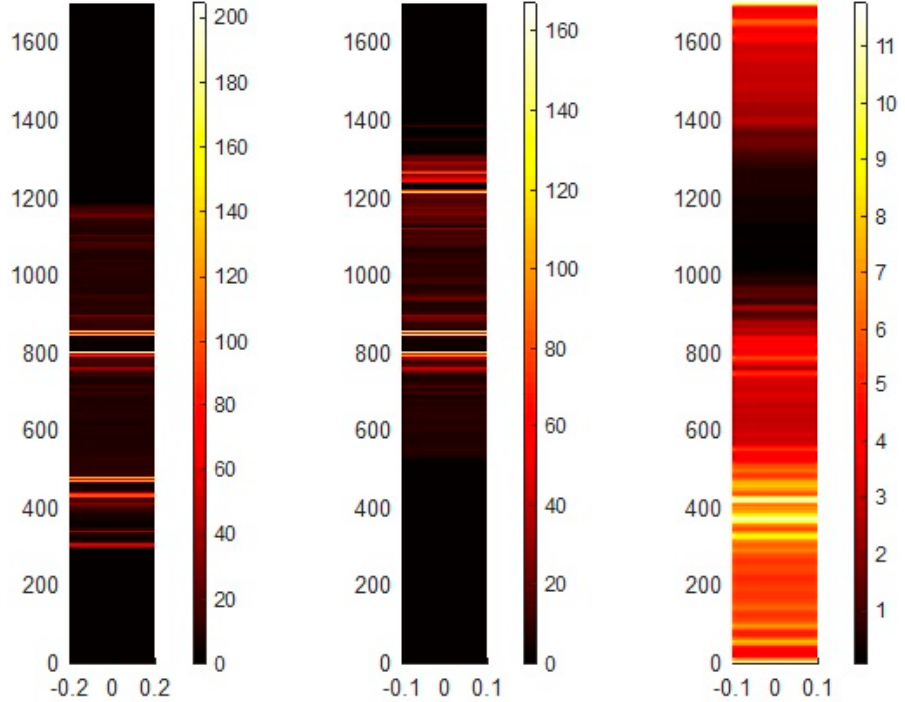
Figure 5. The partial sinograms of M 1 and (cid:101) M 2 for y -axis (left and middle) and their normalized cross-correlation (right). The Y -translation amount is estimated by matching the partial sinograms where α (cid:48) = 90 ∘ .